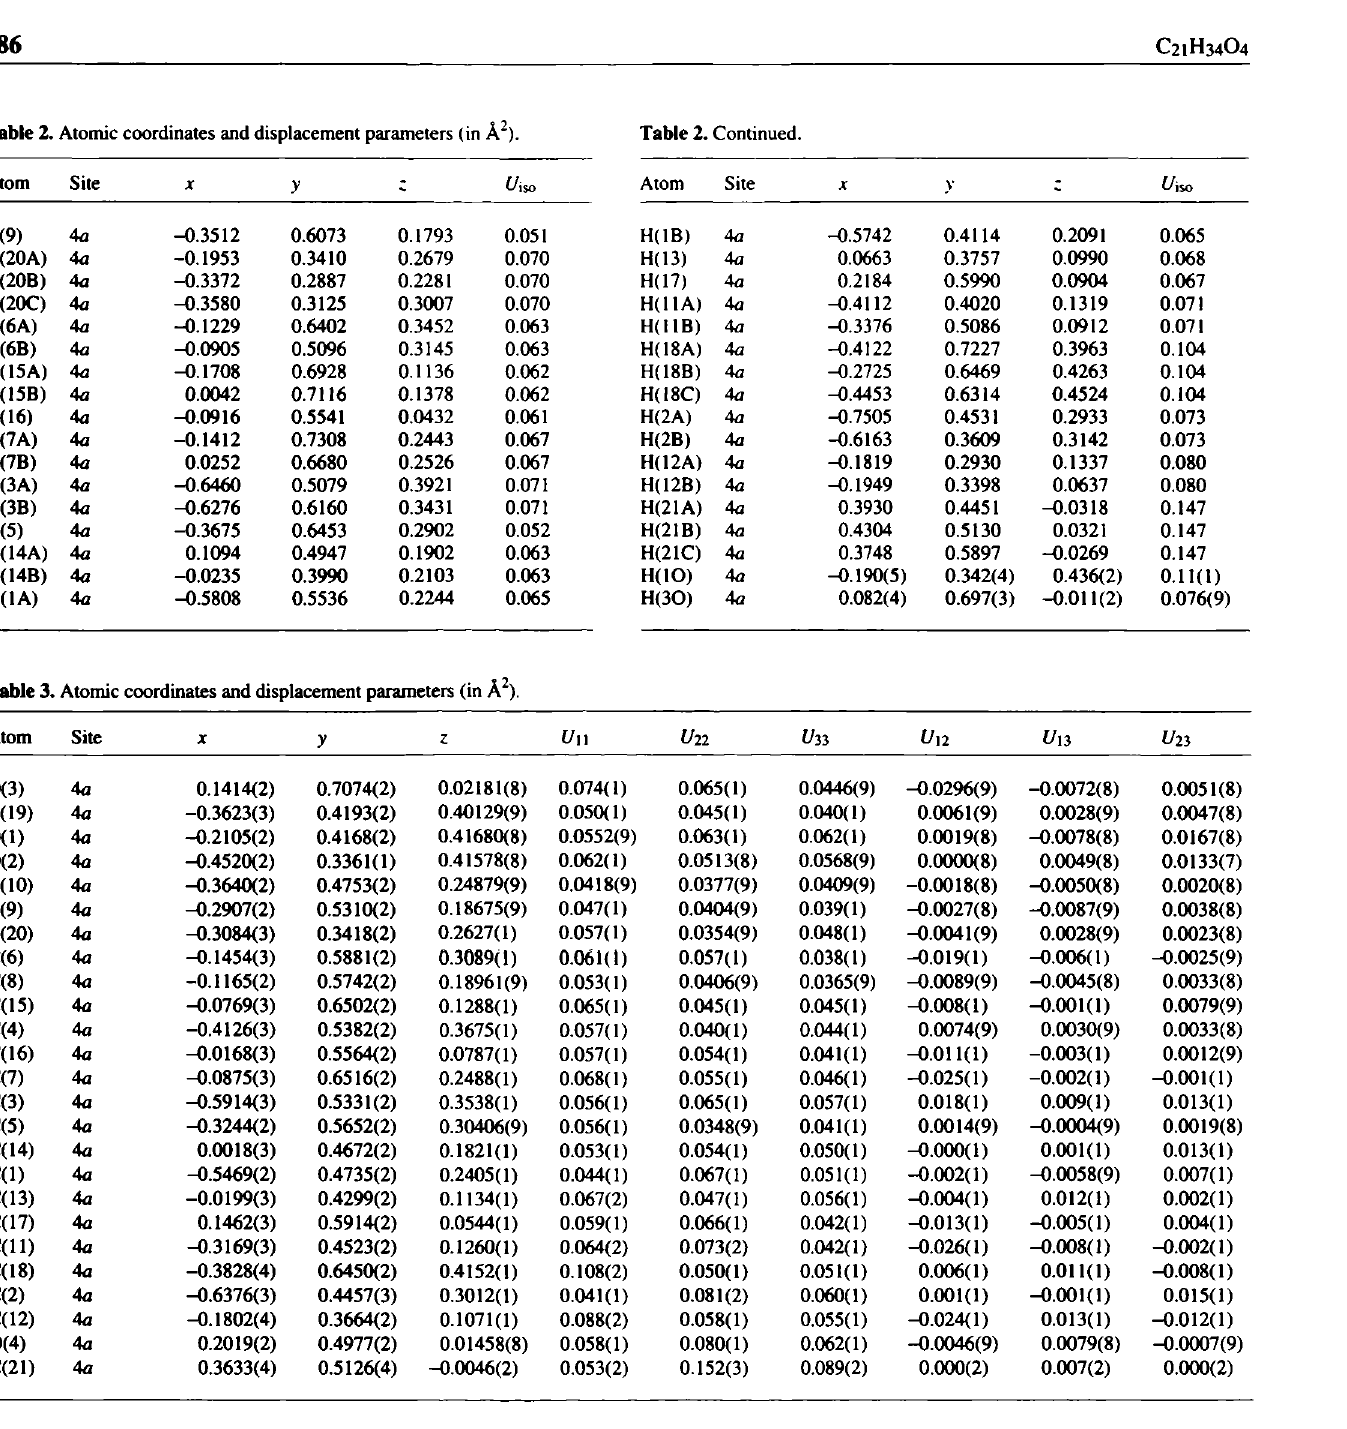
Table 2. Atomic coordinates and displacement parameters (in Â 2 ).